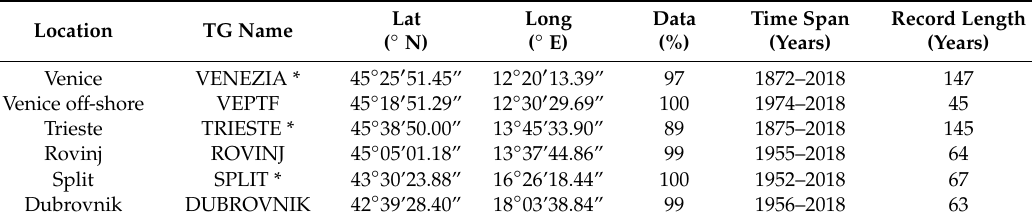
Table 1. Tide gauges considered in Adriatic Sea. Column 1: location name; column 2: TG name; columns 3–4: latitude and longitude; column 5: percentage of available data; column 6: total timespan; column 7: length of record in years. Asterisks in tide gauge (TG) names indicate that the sea level (SL) record has been reconstructed from di ff erent